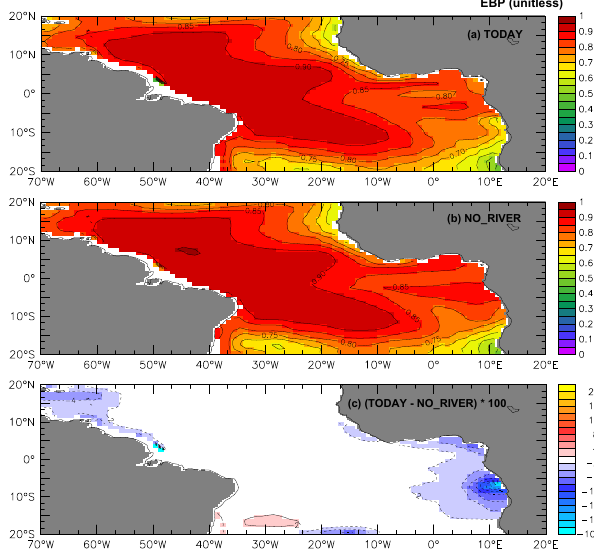
Fig. 9. Mean biological pump efficiency ( E BP , average 1998–2005) (a) the TODAY scenario, (b) the NO_RIVER scenario, and (c) dif- ference in % between the TODAY and NO_RIVER